Question: Sum up the contents of this chart in one sentence.
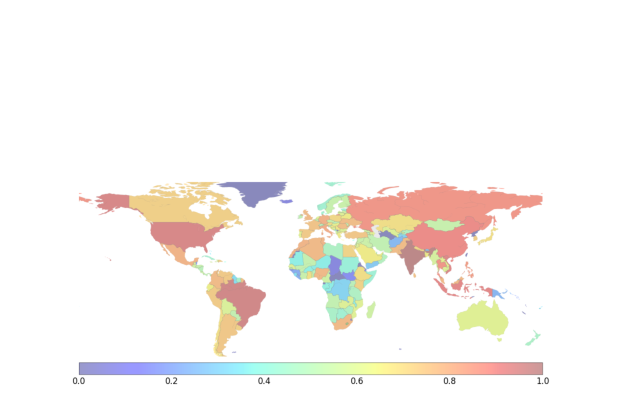
Answer: The distribution of RESIP nodes in a world heatmap.